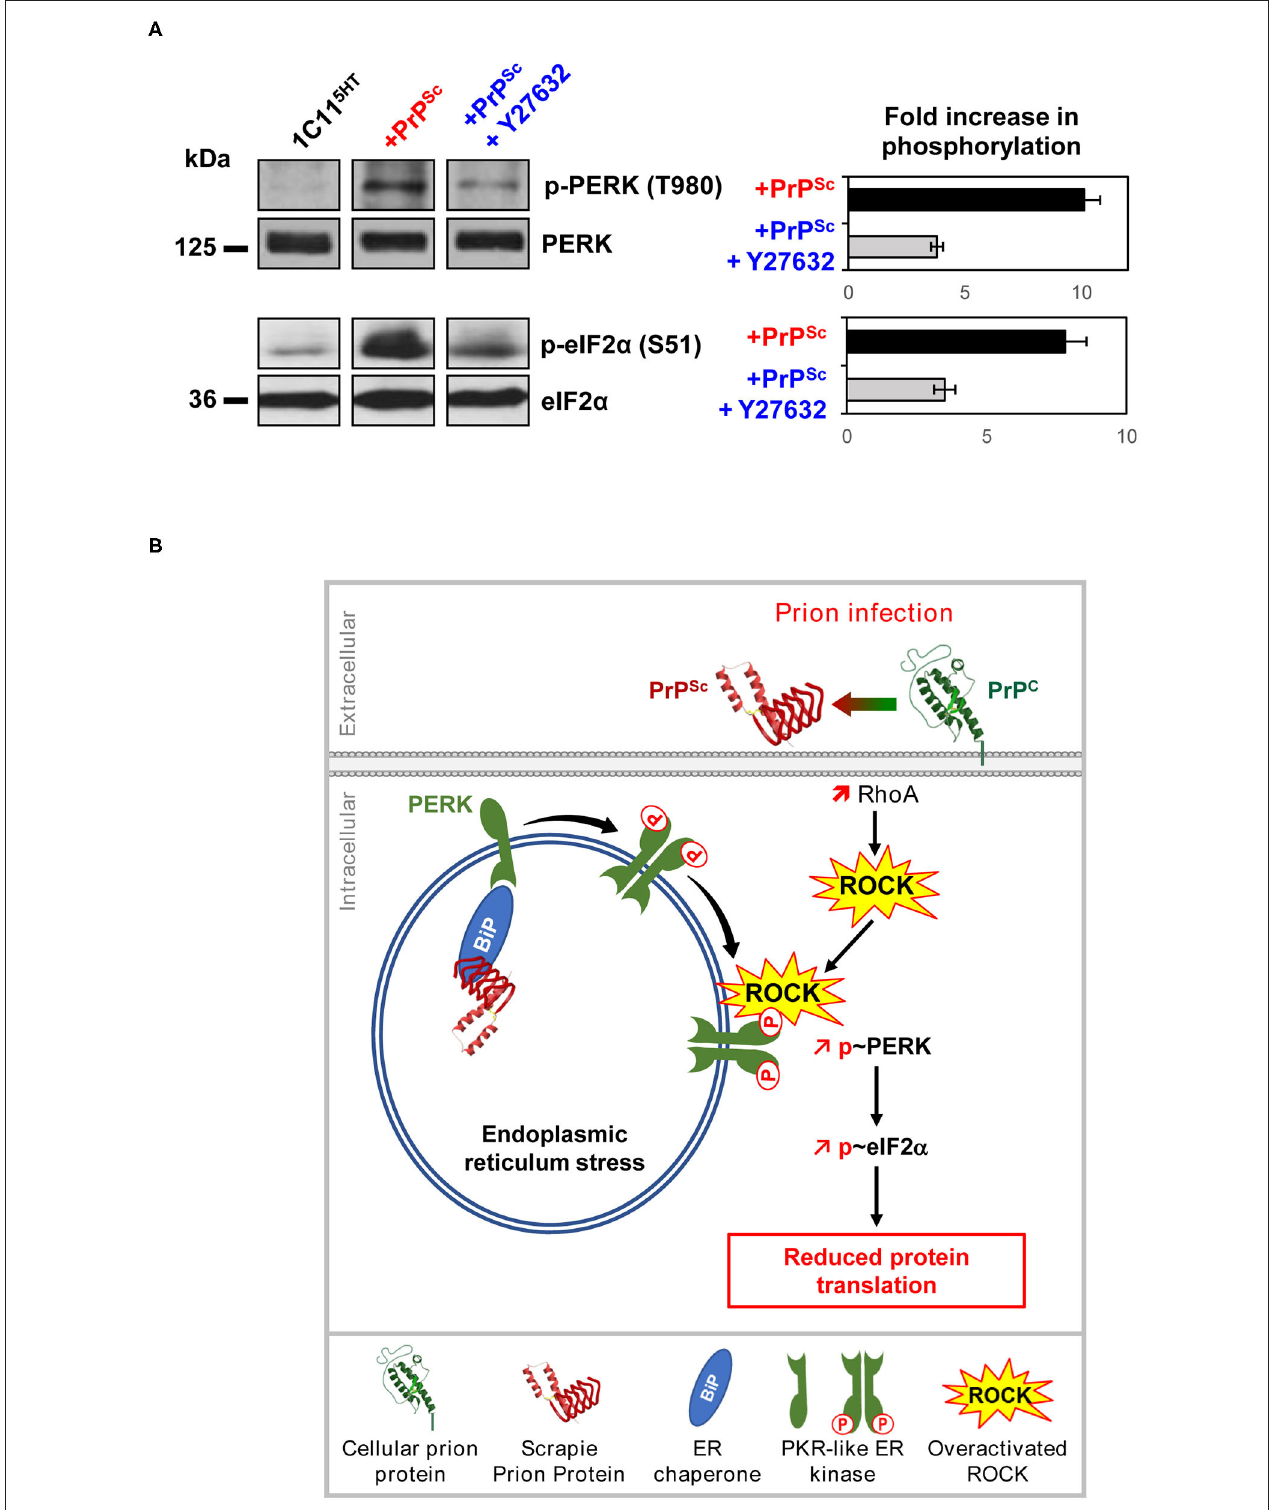
FIGURE 5 | Deregulation of the PrP C -ROCK connection contributes to the endoplasmic reticulum stress and reduces protein translation in prion-infected neurons. (A) In 1C11 5 − HT cells, PrP Sc induces PERK and eIF2 α phosphorylation. ROCK inhibition with Y-27632 (100 µ M) reduces PrP Sc -induced phosphorylation of PERK and